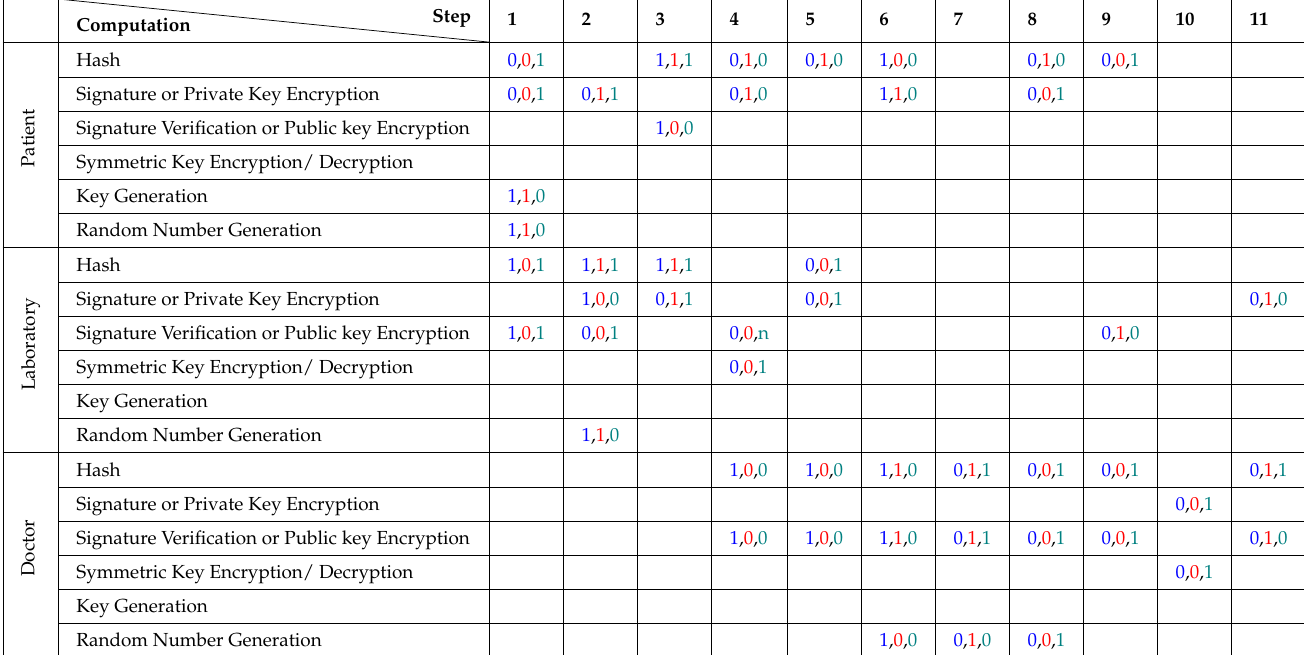
Table 12. Computations performed in the three proposed architectures (Indy, Indy + Fabric and Indy + Fabric +